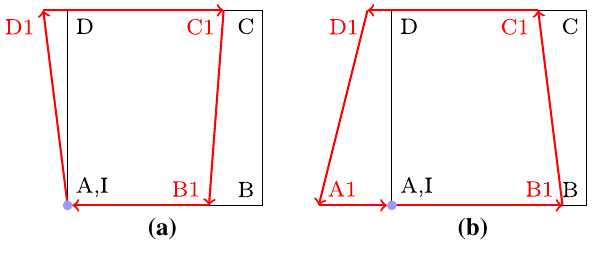
Fig. 4 As seen from observer frame: a clockwise, b counter-clockwise